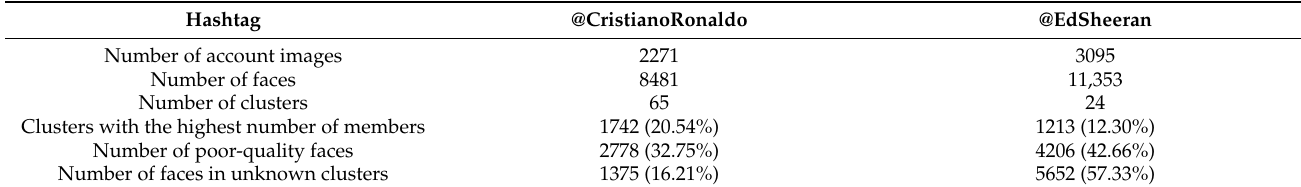
Table 6. Statistics of face